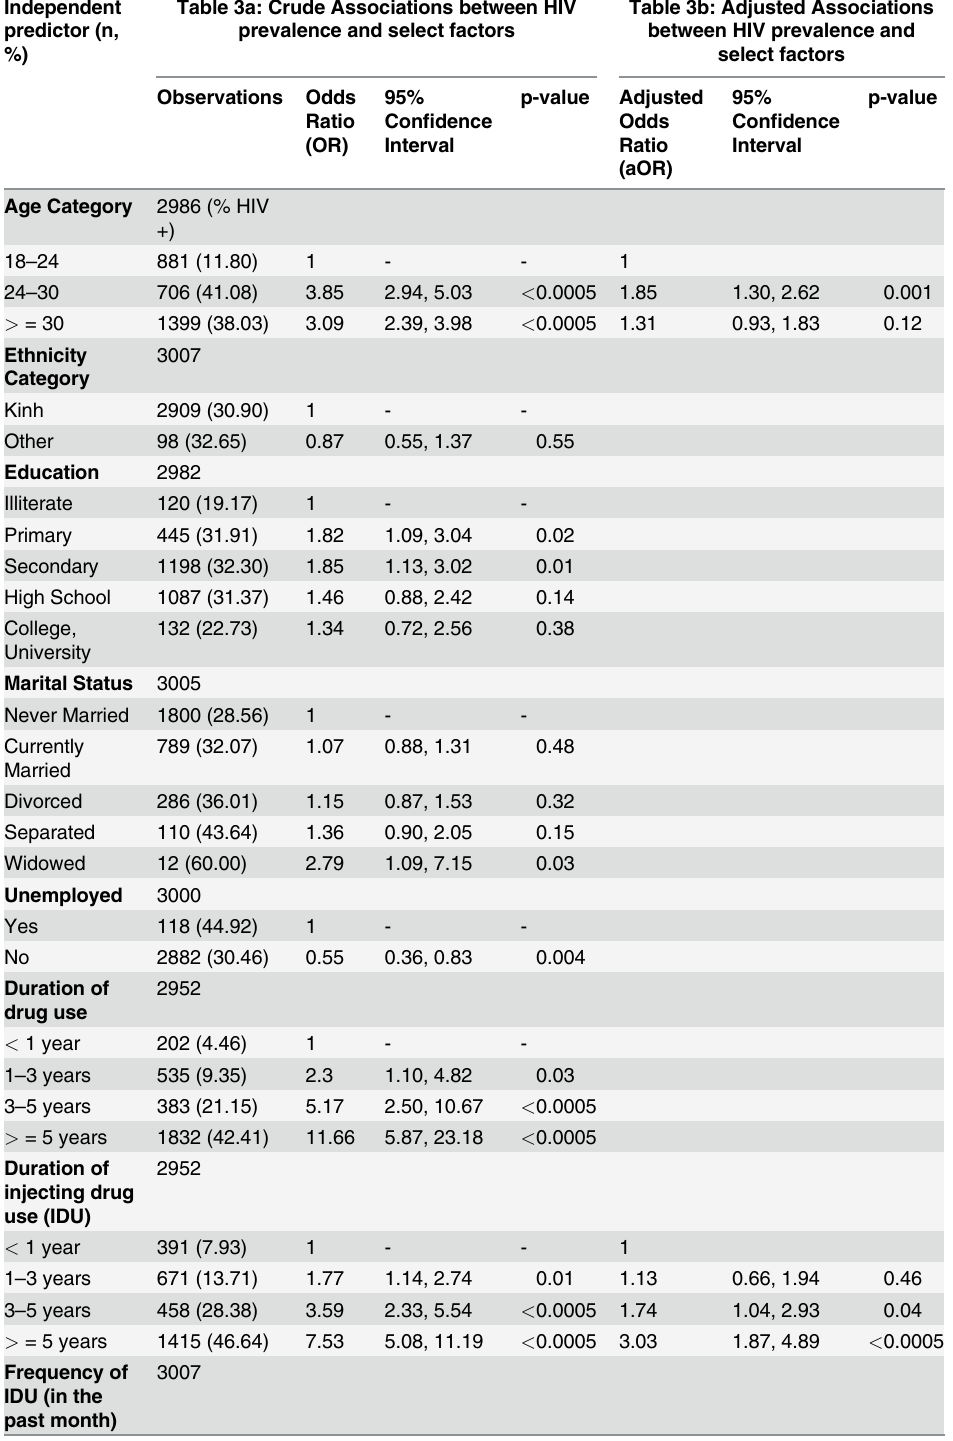
Table 3. Crude and Adjusted Associations between HIV prevalence (outcome) and select factors among MWID in Vietnam. Table 3a: Crude Associations between HIV prevalence and select factors